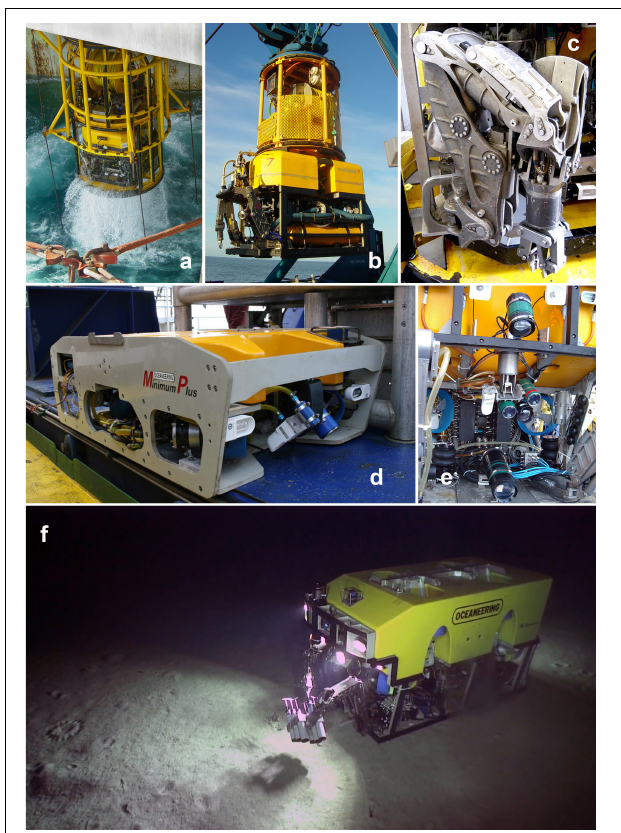
FIGURE 1 | Images of industrial ROVs photographed by the authors. (a) Subsea 7 work-class ROV ( ∼ 2 m tall) being deployed from the Transocean Jack Bates semi-submersible drilling rig. (b) Subsea 7 Centurion work-class ROV ( ∼ 2 m tall) on the MV Nordica . (c) Close up of Schilling Robotics Conan 7-function ROV manipulator ( ∼ 1 m tall as imaged). (d) Oceaneering Minimum Plus observation-class ROV ( ∼ 50 cm tall). (e) Detail of Oceaneering Magnum ROV ( ∼ 2 m tall) showing video and still cameras on pan-and-tilt unit (center) and lights. (f) Underwater image of Oceaneering Millennium ROV ( ∼ 2 m tall) taking push core samples of the seabed at around 1,700 m deep offshore Tanzania (taken with another